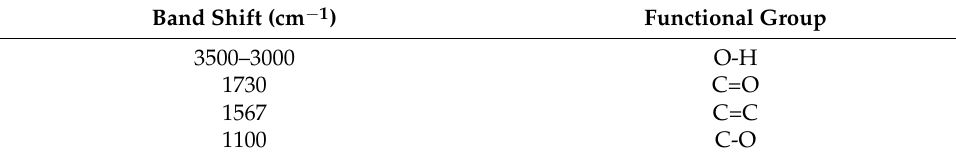
Figure 5. FTIR spectra of the GO60 and GO90 samples. Characteristic vibrational modes of graphene oxide are observed. Table 3. Characteristic vibrational modes and their energies of GO60 and GO90.